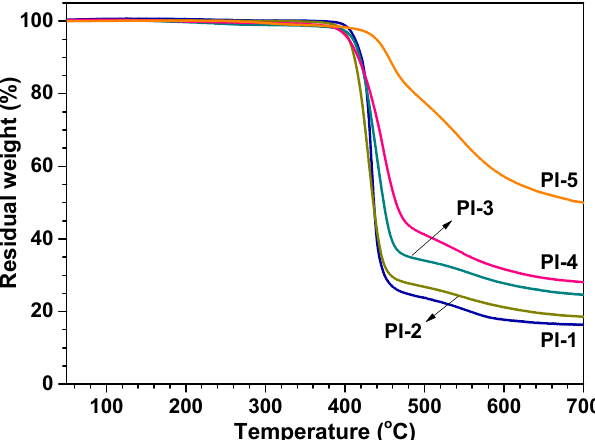
Figure 2. Thermogravimetric analysis (TGA) curves of semi-alicyclic polyimide films in nitrogen. Thermal dimension stability is another key factor for PI films when applied as flexible